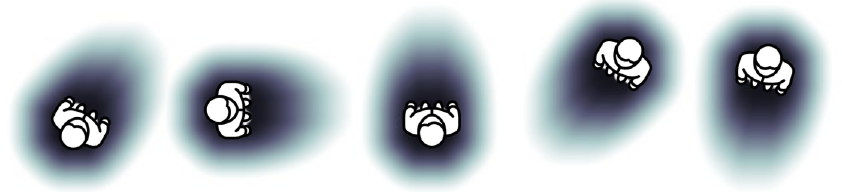
Figure 13. Representation example with two-Gaussian mixture model. The person is generated with different orientations in space.